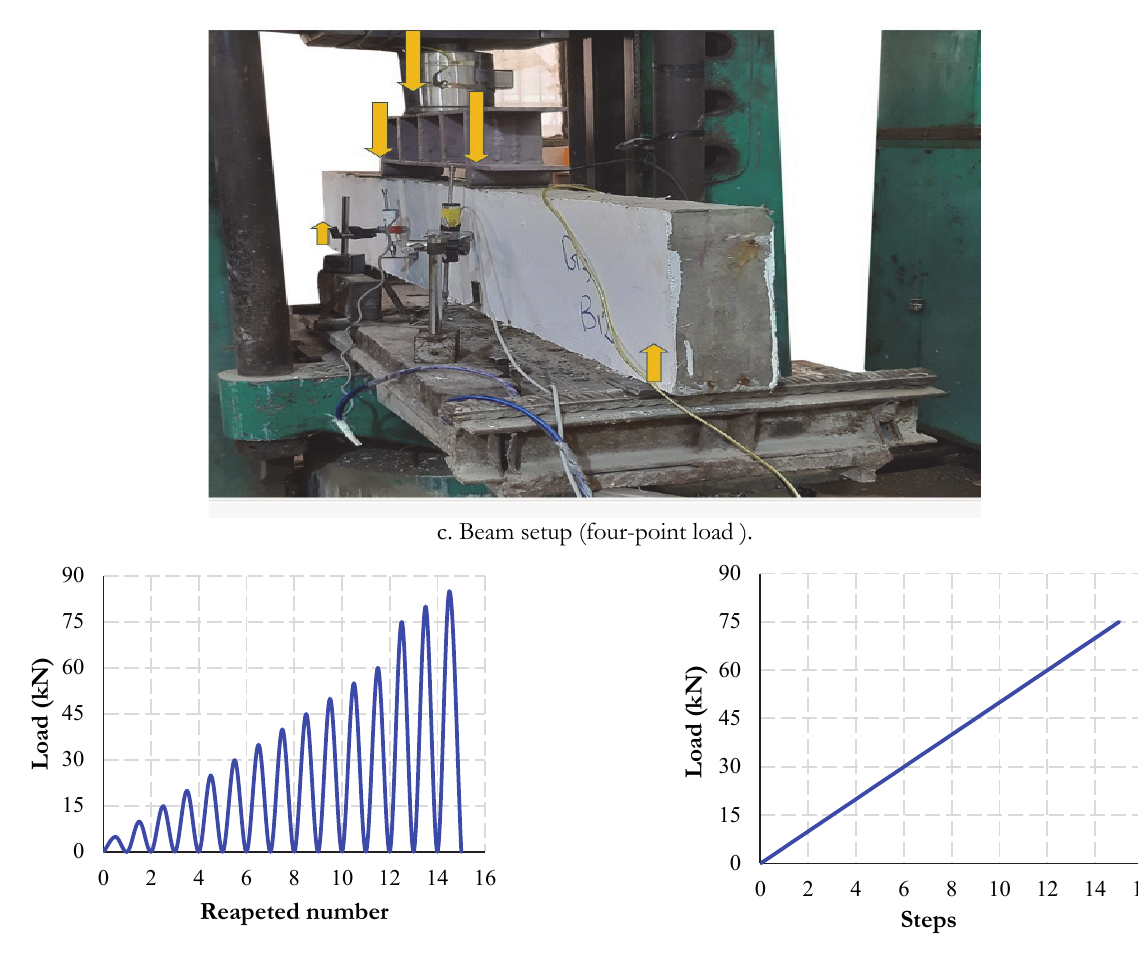
Figure 2: (a) Beam geometries details, (b) Beam reinforcement details, (c) Beam setup, (d) Repeated load, and (e) Statice load.